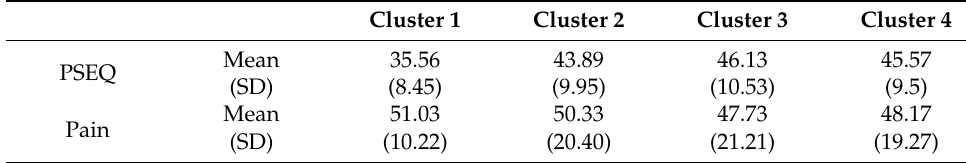
Figure 8. Evidence framework of Bayesian inference (optimum number of hidden node of 9, indicated by red dashed line). Table 5. Descriptive statistics (mean (SD)) of PSEQ, and pain level for each